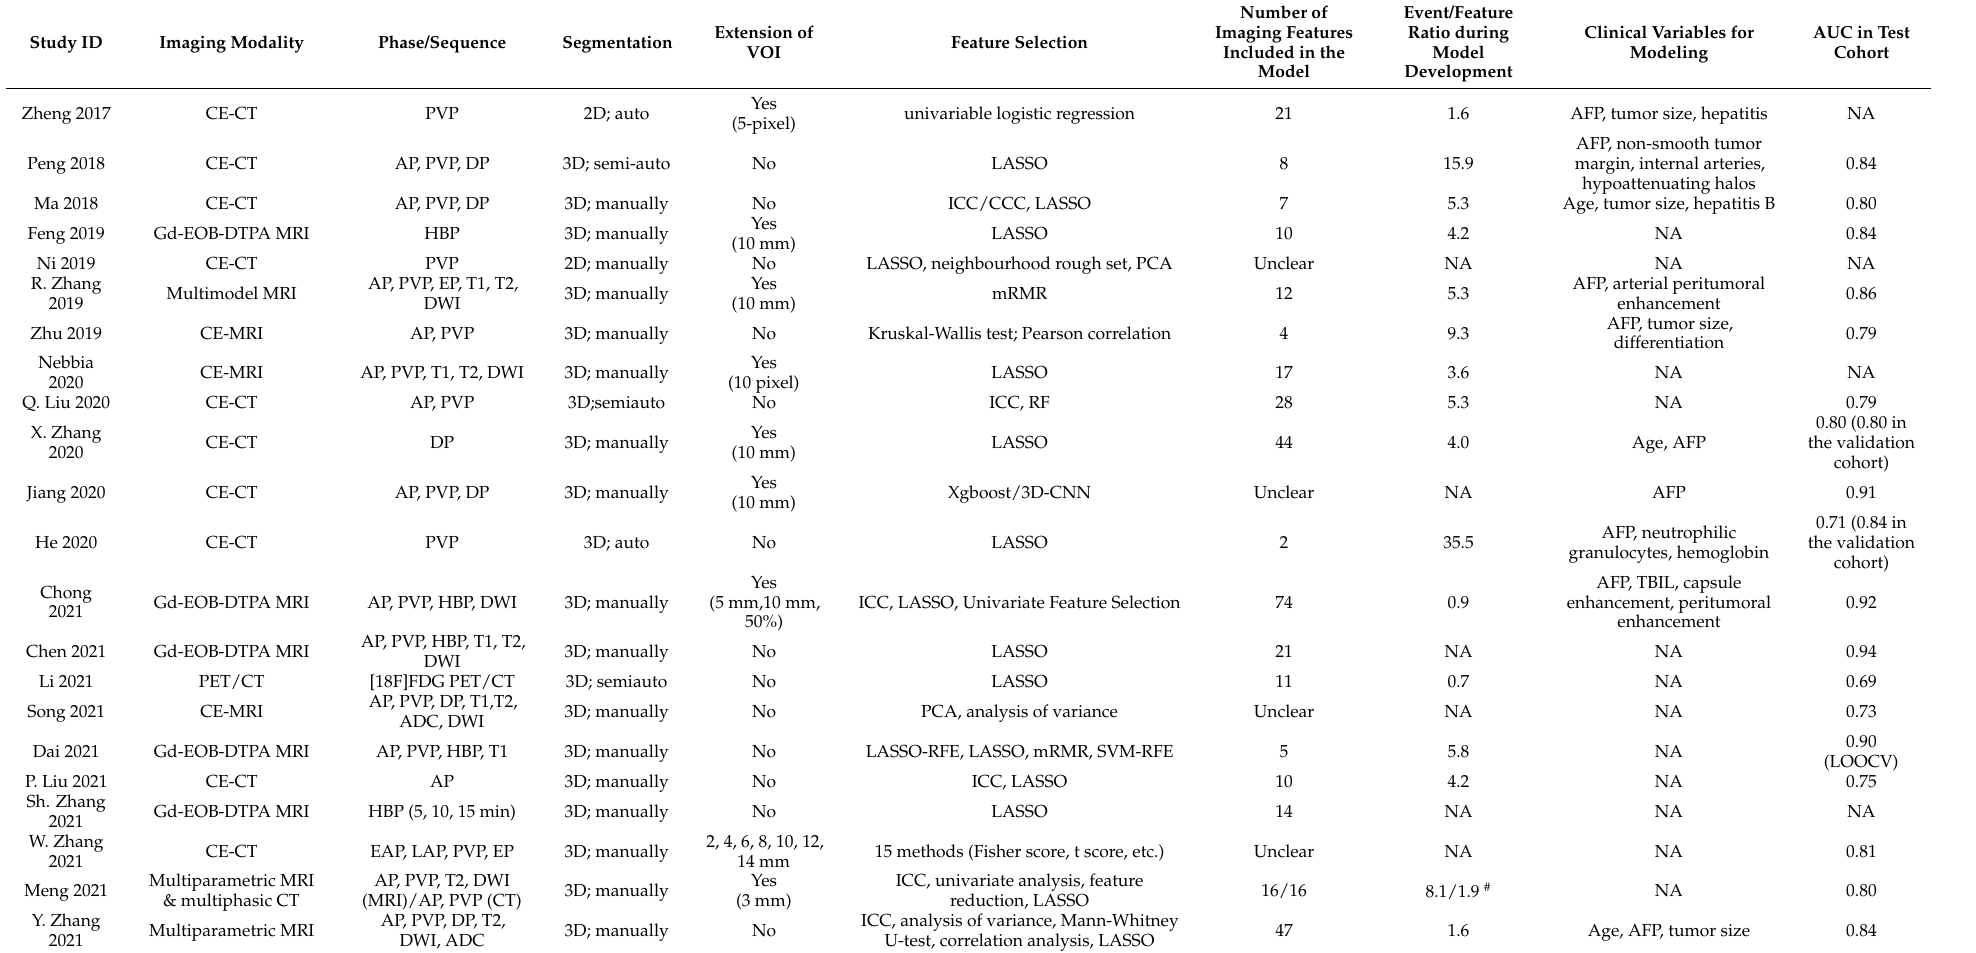
Table 2. Characteristics of the radiomics research for microvascular invasion (MVI)